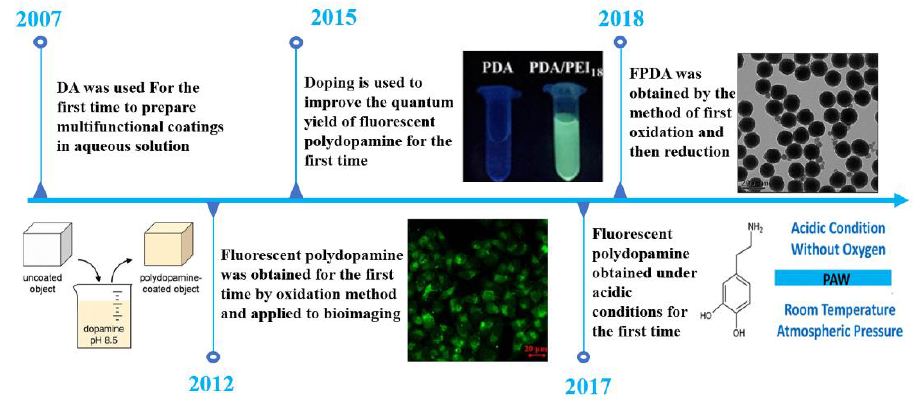
Figure 1. A brief timeline for the development of fluorescent polydopamine.